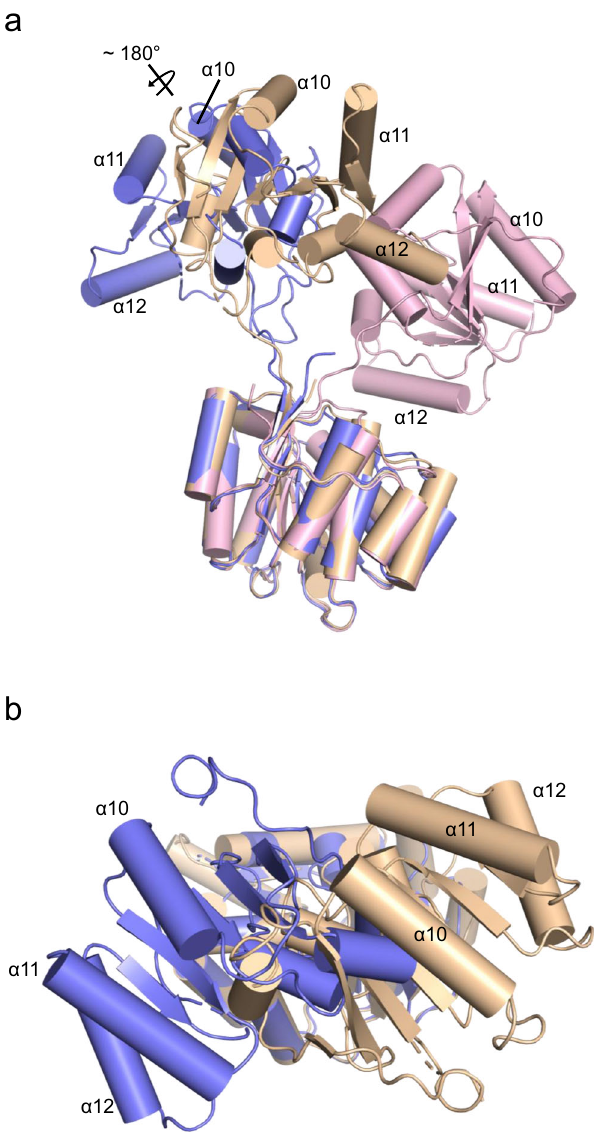
Fig. 2 BLF1 C94S binds to a twisted conformation of the two eIF4A Δ 20 domains. Superposition of three different eIF4A structures on the basis of their N-terminal domains reveals the quite different positions of the C-terminal domain. Helices α 10, α 11, and α 12 of eIF4A are labeled to enable the different orientations to be seen. a In the apo yeast eIF4A, (PDB:1FUU; wheat) the two domains adopt an open conformation whilst a complex of yeast eIF4A with eIF4G (PDB:2VSX; pink) reveals a closed conformation for eIF4A. Human eIF4A in complex with BLF1 (PDB:7PQ0; blue) adopts a different open conformation in which the eIF4A domains are twisted compared to apo. The approximate axis of rotation about which the C-terminal domain of eIF4A twists in the complex with BLF1 is indicated. b A view of the superposition between the N-terminal domains of apo yeast eIF4A and Human eIF4A in complex with BLF1 (background), shown in wheat and blue respectively, highlighting the approximate 180° rotation relating their C-terminal domains in the